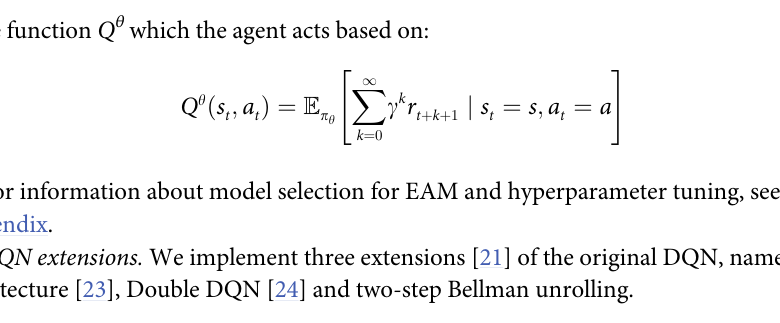
of historical prices s and news sentiments ρ of the designated asset, and acts to trade with an action a sig t t t t using new prices s t and signals a sig . t t